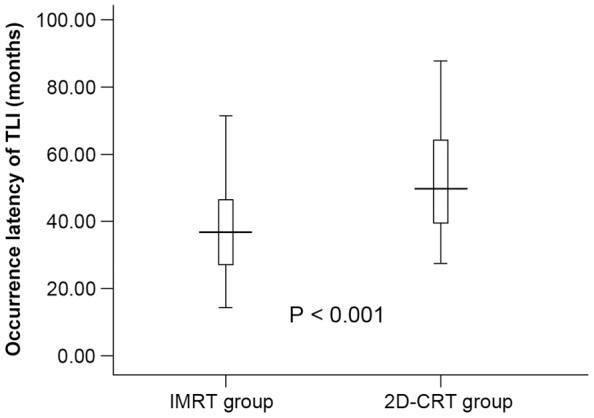
Latency of occurrence of temporal lobe necrosis.Patients treated with intensity-modulated radiotherapy (IMRT, left) vs. two-dimensional conventional radiotherapy (2D-CRT, right). Standard error bars are included and the thick horizontal line for each set of data points represents the median latent period.